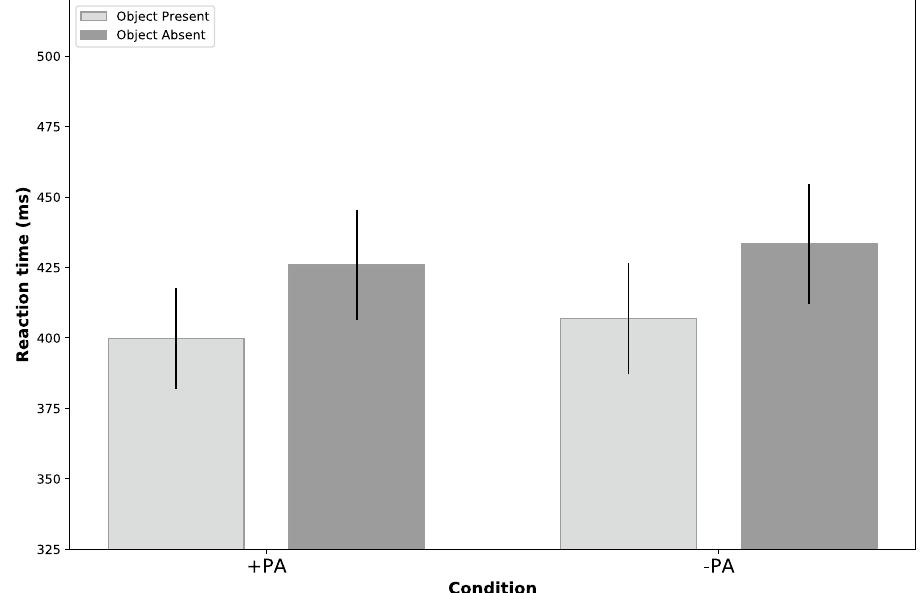
Figure 2. Average reaction times. On the X-axis there are the two conditions: + PA, when the observer’s perceived having access to the object’s potential location, and −PA where the observer is perceived having no access to it. Y-axis shows reaction time in milliseconds. Error bars indicate 95% CI in each condition. Post hoc analysis revealed that reaction times were significantly lower (in the + PA condition (t(52) = −2.833, p = 0.07, d = −0.389) and when the object was present (t(52) = −3.137, p < 0.001, d = 0.964). This pattern of results suggests that the perceived access of an observer to a particular information that participants processed had a facilitating effect on the speed of object